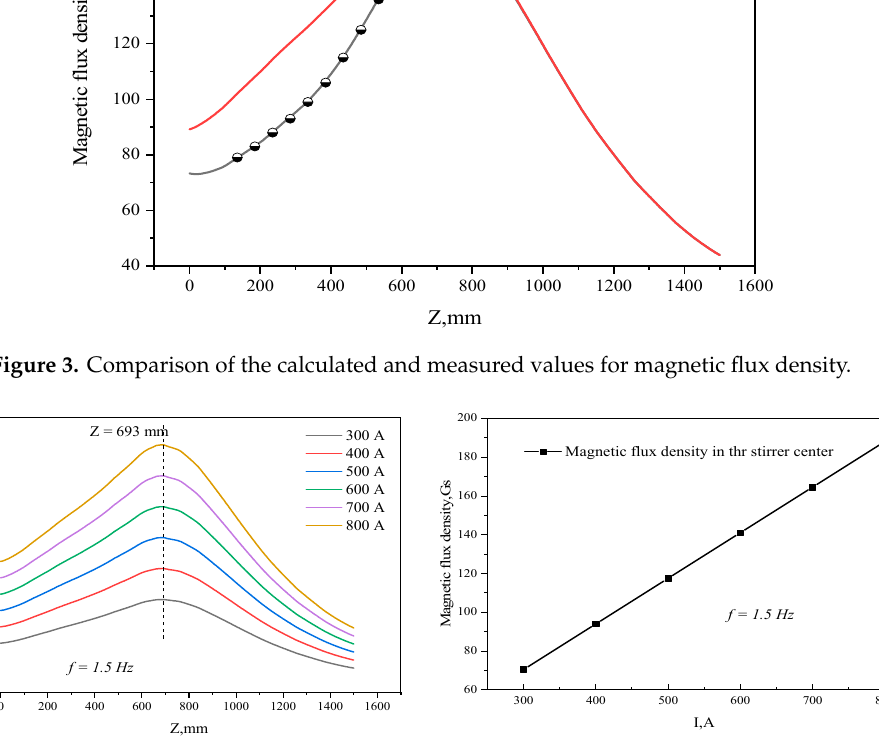
Figure 5. Temperature contour and flow streamline on wide symmetry plane: ( a ) single-port nozzle; ( b ) five-port nozzle. Figure 6 indicates the maximum velocity at the solidification front of each mold cross section of different current intensities. The washing effect of the molten steel at the solidification front helps to melt the frontier of the dendrite; then the broken dendrites will flow with the molten steel, which can enhance the nucleation of equiaxed crystals [18]. From Figure 6b–d, we see that, as the current intensities increase, the horizontal swirling flow generated increases as well, which results in an increase in the size of holes, due to the washing velocity of the solidification front. Figure 6a shows the jet flow zone of the side holes. As the current intensity increases to 600 A, the induced horizontal swirling flow can effectively slow down both the velocity at the port exit and the washing effect. However, when it is increased to 800 A, there appears to be an enhanced washing effect due to the excessive swirling flow. For the contribution of high outflow velocity from the side holes, the washing effect of the five-port nozzle on the solidification front is much more powerful than that of the single- port nozzle, which is favorable for generating free nucleation.